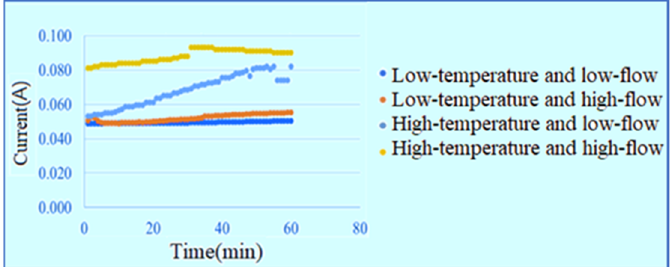
Figure 9. Current data of power supply.